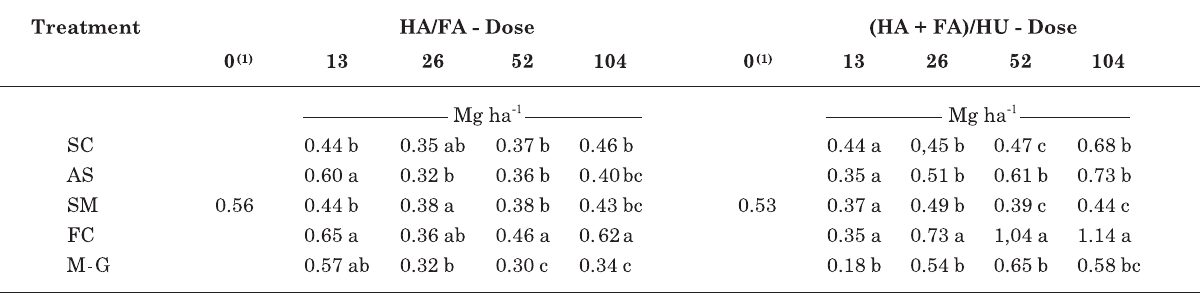
(1) The ratios between the HS at the 0 Mg ha -1 dose were calculated from the HA, FA and HU contents originally found in the soil; averages followed by the same letter in the column did not differ by Tukey test at 5 %; SC: simple compost; AS: SC + NPK, where N: ammonium sulphate; SM: SC + powder from serpentinite and mica schist rocks; FC: filter cake + sugarcane bagasse; M-G: castor oil plant residue + sugarcane